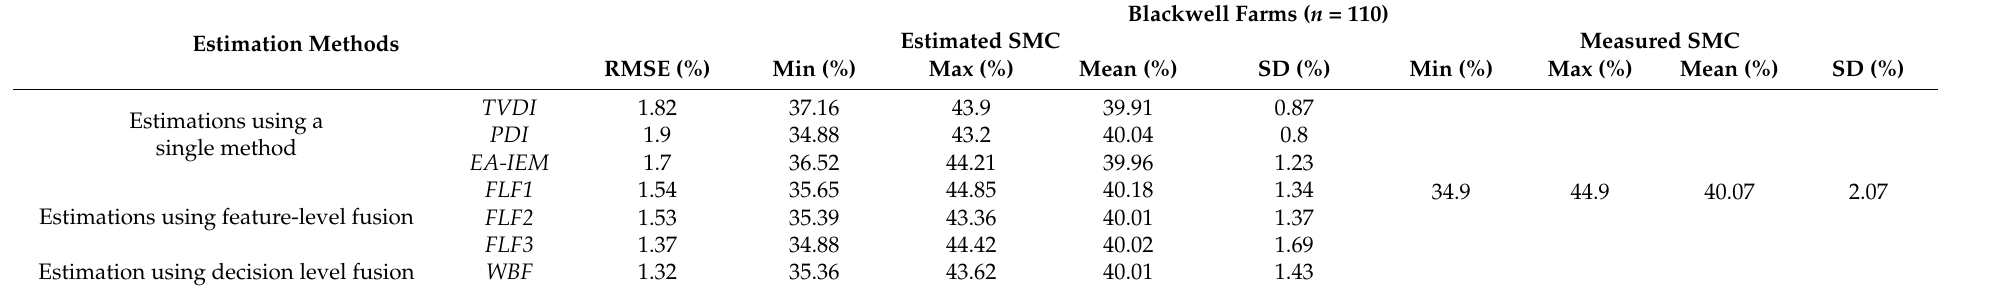
Table 7. The results of each of the used estimation methods in the Blackwell farms dataset.